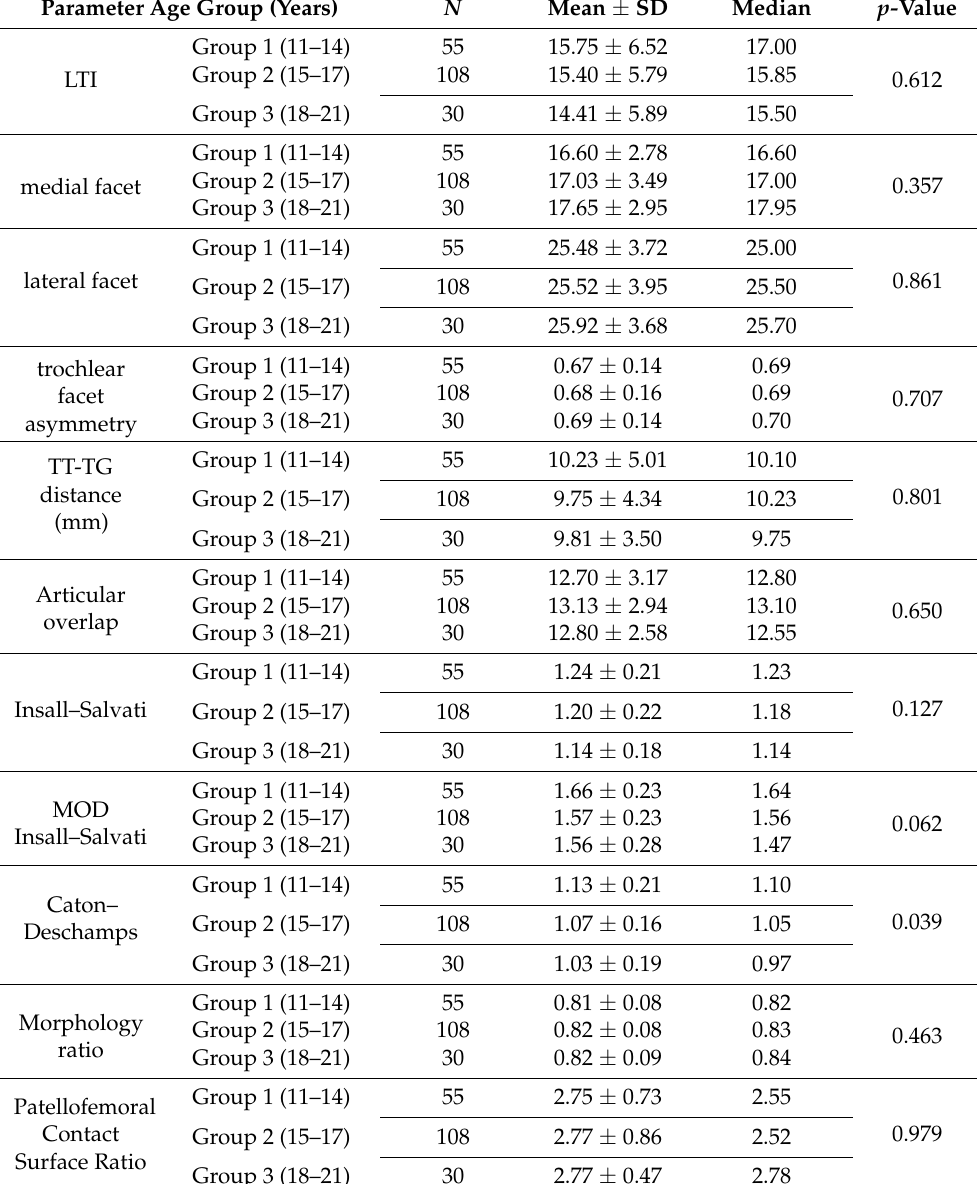
Table 2. Morphometric parameters by age